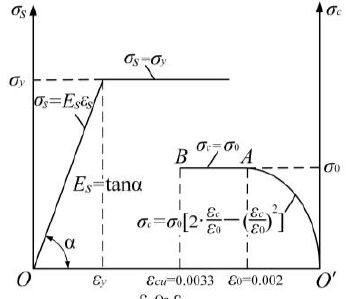
Figure 17. Typical stress – strain constitutive relationships of reinforcement and concrete. The stress and strain state characteristics of the compressed concrete and tensile steel bars of the pile at this stage are shown in Equation (23). Combining Equations (12) and (23), it can be seen that the strain ( s be used as the boundary sign between Stage I and Stage II.